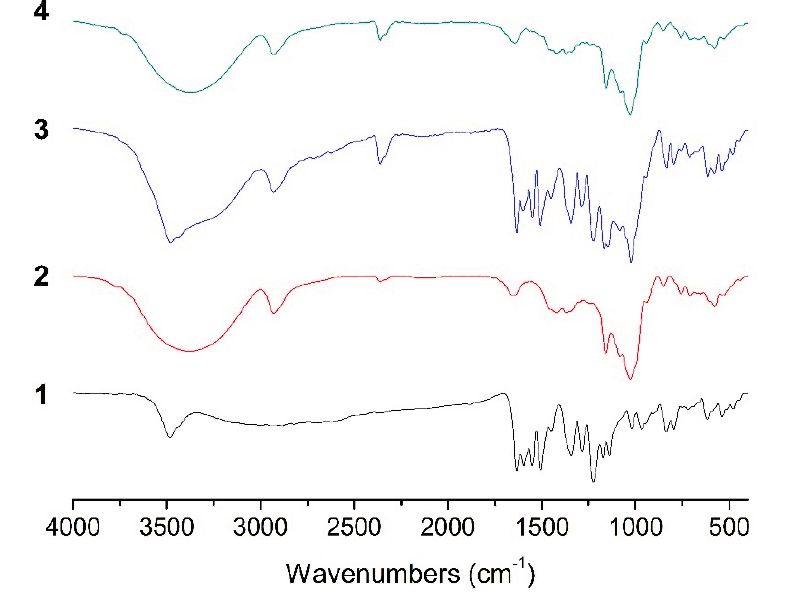
Figure 5. IR spectra of (1) ILTG, (2) G2- β -CD, (3) the ILTG/G2- β -CD physical mixture, and (4) the ILTG/G2- β -CD inclusion